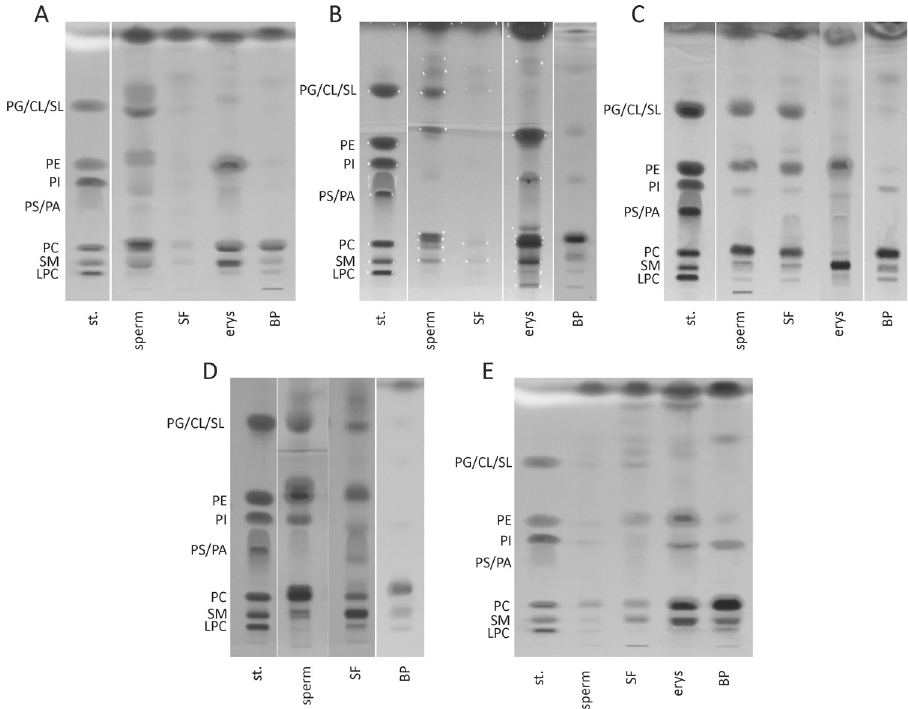
Fig 2. TLC-based separation of lipid-containing fractions of sperm, seminal fluid, erythrocytes and blood plasma samples. Extracted lipid-containing fractions from sperm, SF, erythrocytes and BP samples of boar (A), stallion (B), bull (C), man (D) and lion (E) were separated on normal phase HPTLC glass plates (Merck KGaA, Darmstadt, Germany) using chloroform/ethanol/water/triethylamine (30:35:7:35, by vol.) as the mobile phase. For visualization of the separated lipids, the plates were dipped into primuline solution (Direct Yellow 59, Sigma-Aldrich, Taufkirchen, Germany; 50 mg/l in acetone/water (80:20, by vol.)), dried under room conditions for 15 min and illuminated with UV light (366 nm). Lipid spots were marked with a pencil as demonstrated in B (white dots). For original TLC pictures see S9 Fig. BP–blood plasma, SF–seminal fluid, st–standard lipid mixture.